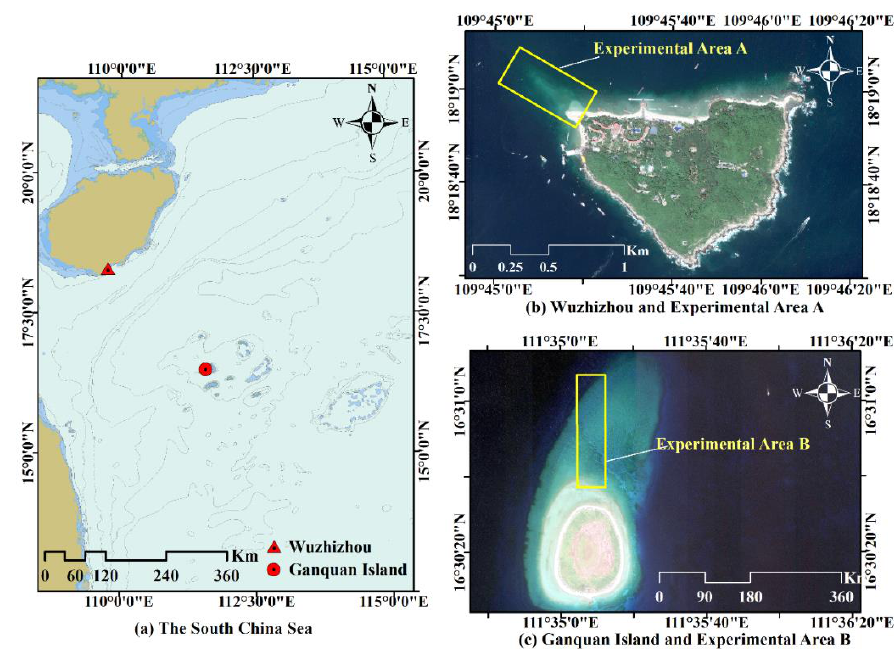
Figure 9. The experimental areas.